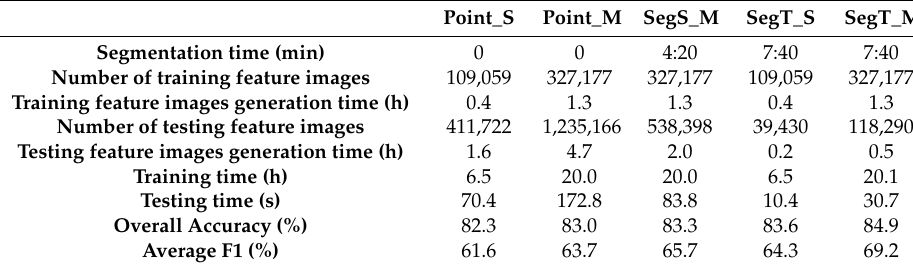
Table 4. Comparison of the computation time for each strategy.